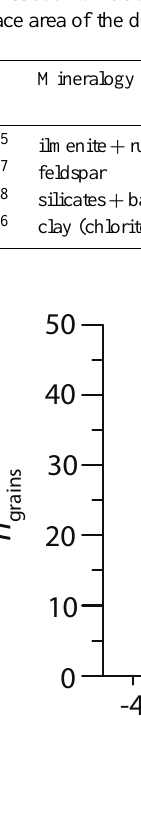
Fig. 7. Comparison of model accuracy (blue bars) with expected error from a normal distribution (black